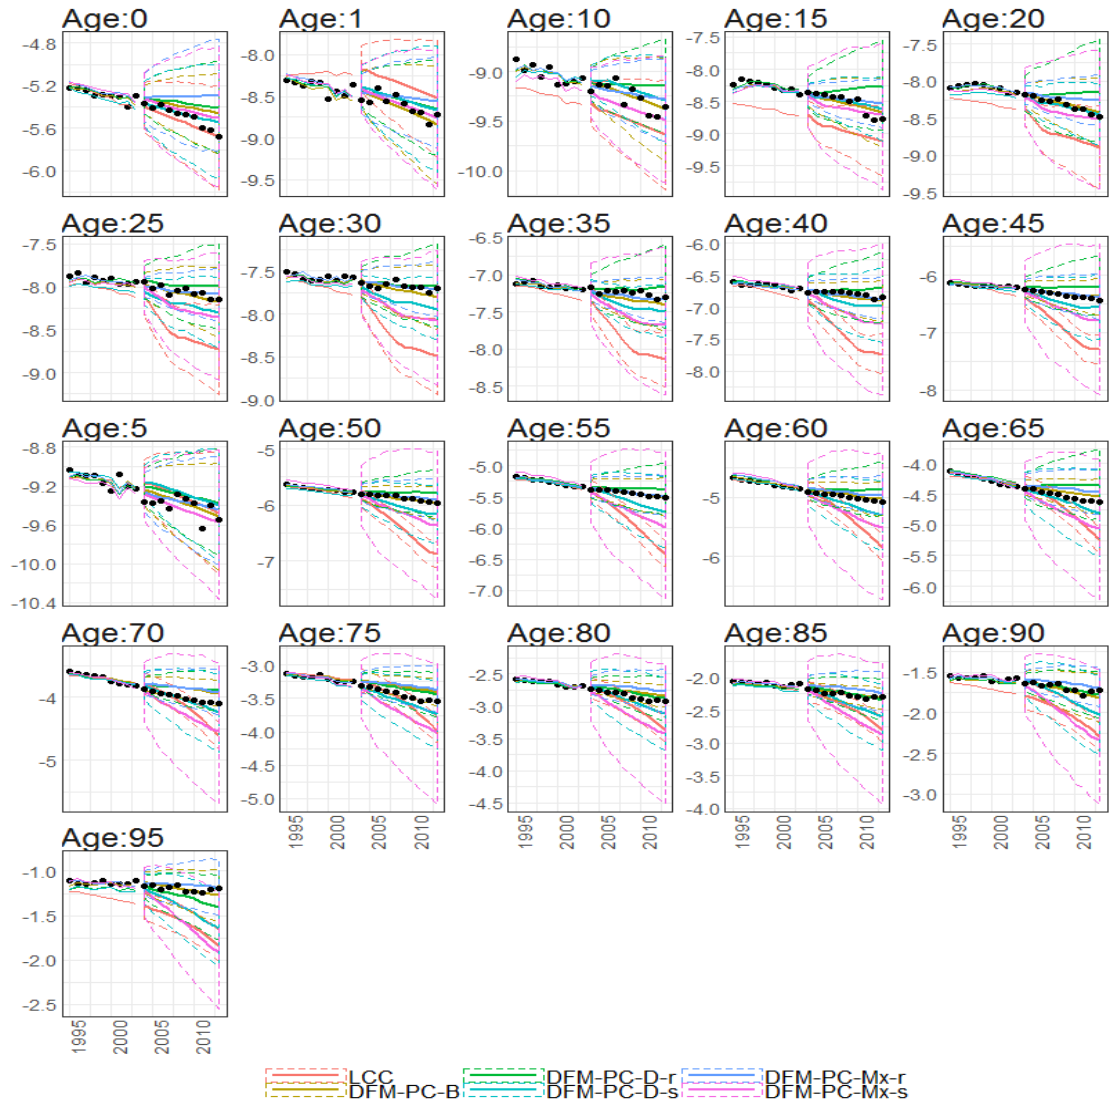
Figure 37. 10-year out-of-sample forecasted log death (y axis) rates of different age groups (different subplots) under different models (colours of lines) with corresponding prediction intervals. Calibration period: